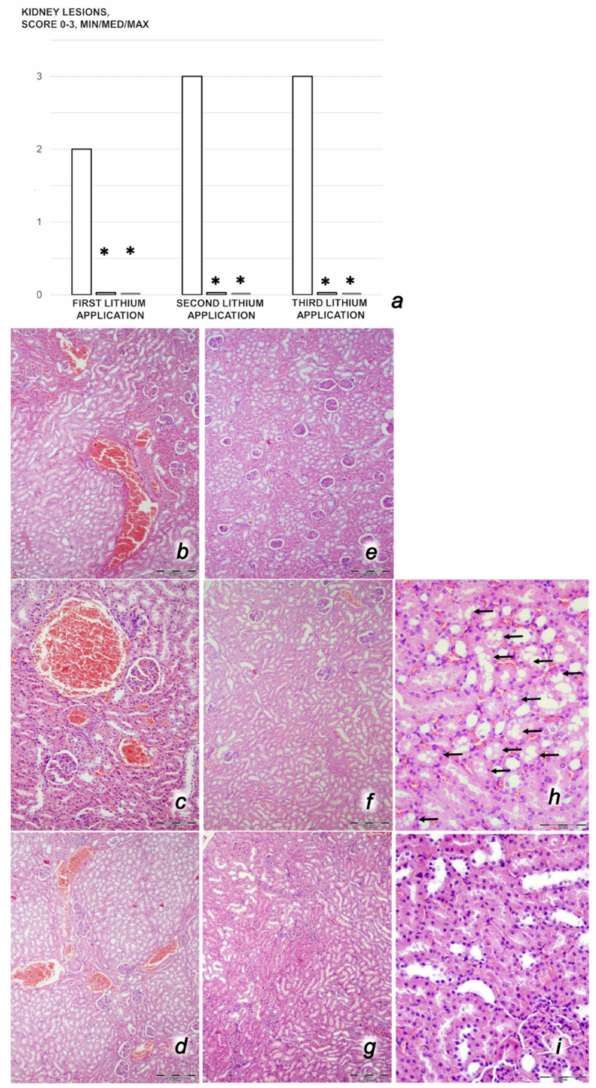
Figure 7. Kidney pathology. Microscopy scoring of the lesions of the kidney (scored 0–3) Min/Med/Max, ( a ) in the rats treated with lithium sulphate (500 mg/kg/day intraperitoneally for 3 days) that received medication (BPC 157 10 µ g/kg (light gray bars), 10 ng/kg (dark gray bars); saline 5 mL/kg (white bars)) given intraperitoneally. Six rats/group/interval. * p < 0.05, at least, vs. control. Kidney histology in control lithium-treated rats ( b – d , h ) and BPC 157- and lithium-treated rats ( e – g , i ); first lithium application ( b , e ); second lithium application ( c , f ); third lithium application ( d , g , h , i ). A marked congestion was found in controls after each of the lithium administrations. Contrarily, lithium-treated rats that received BPC 157 regimens presented normal tissue or minimal congestion. Illustrative presentation of the marked congestion and vacuolization of the renal tubular epithelia with degenerative changes in control lithium-treated rats after the third lithium administra- tion ( h ) (arrows) and normal appearance of the renal tubules in lithium-treated rats that received BPC 157 regimens ( i ) (HE; magnification × 100, scale bar 50 µ m ( b – g ); magnification × 400, scale bar 20 µ m ( h , i